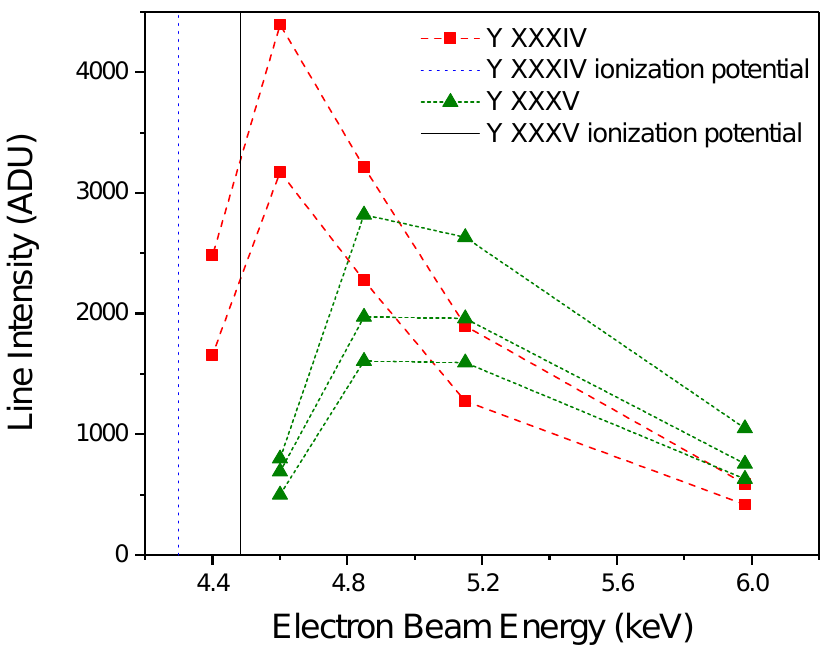
Figure 3. Line intensity plotted as a function of electron beam energy for three Y XXXV lines (green triangles) and two Y XXXIV lines (red squares). The solid (black) and dotted (blue) vertical lines depict the ionization potential of Y XXXV and Y XXXIV,